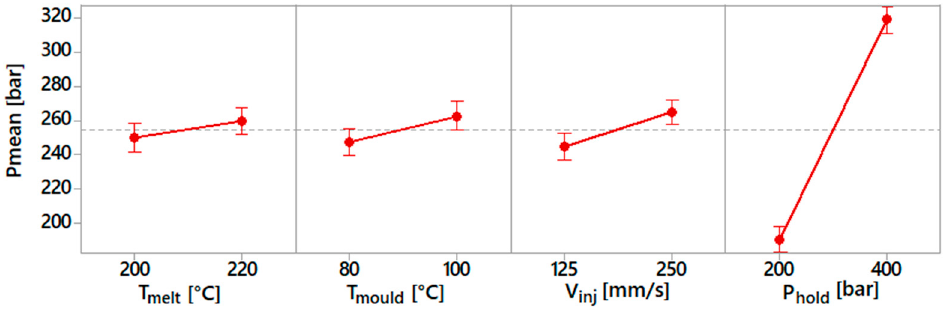
Figure 10. Main e ff ect plot for mean injection Figure 10. Main effect plot for mean injection pressure.